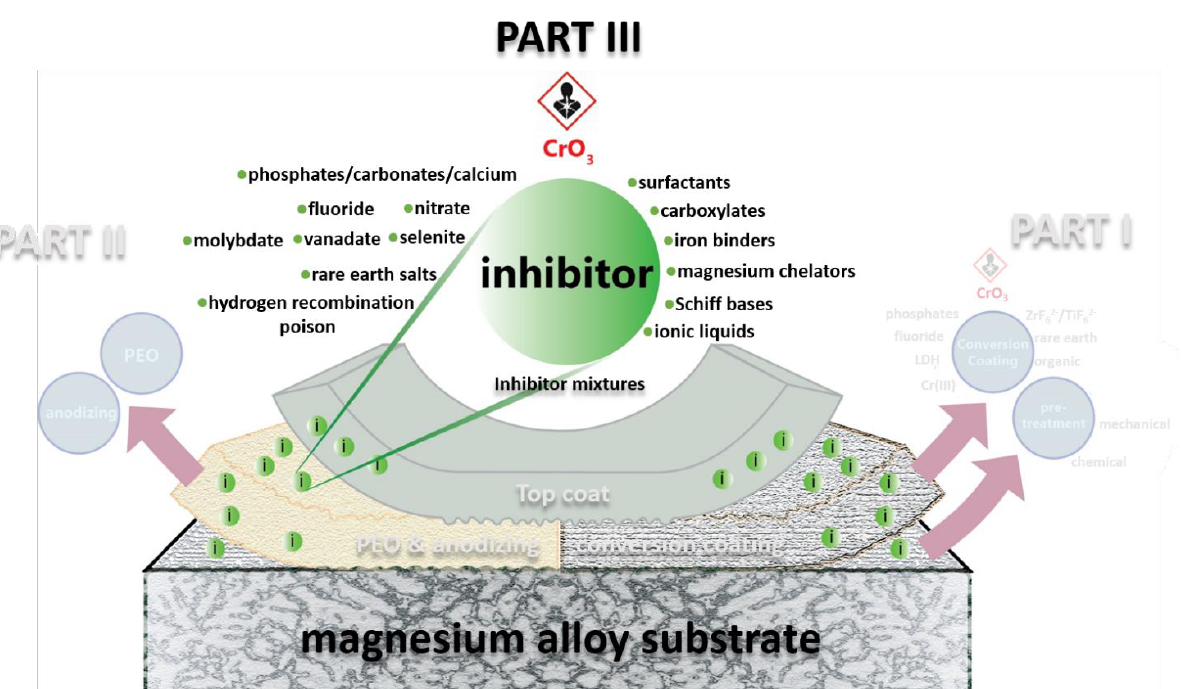
Figure 1. Schematic of review trilogy. This work, as PART III of the review, has been highlighted with more vivid colors, in contrast to the dimmed color of PART I and PART II .